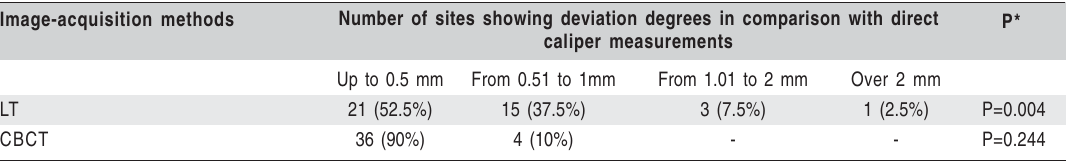
Table 1- Comparison between data for image-acquisition methods and direct caliper control measurements.